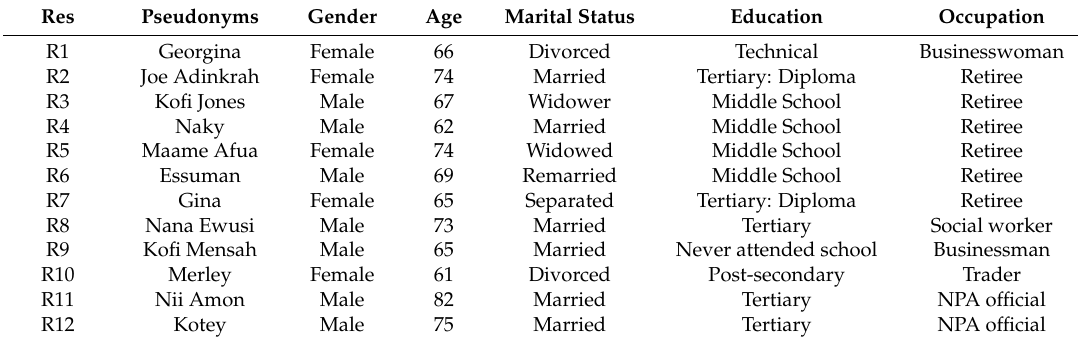
Table 2. Participant